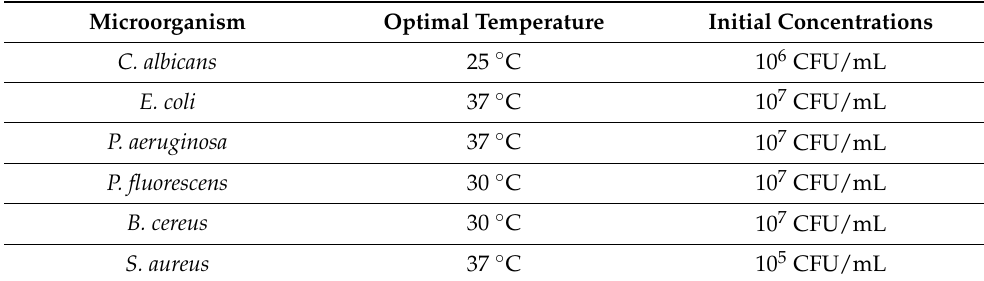
Table 5. Optimal conditions and initial concentrations of microorganisms for quantitative determina- tion of antimicrobial